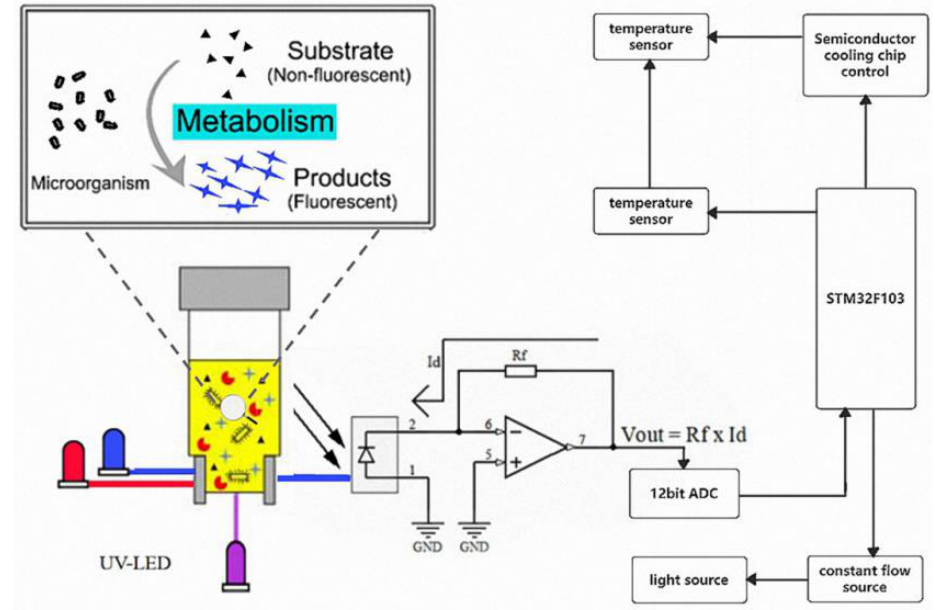
Figure 1. Overall design block diagram of microbial photoelectric detection system.